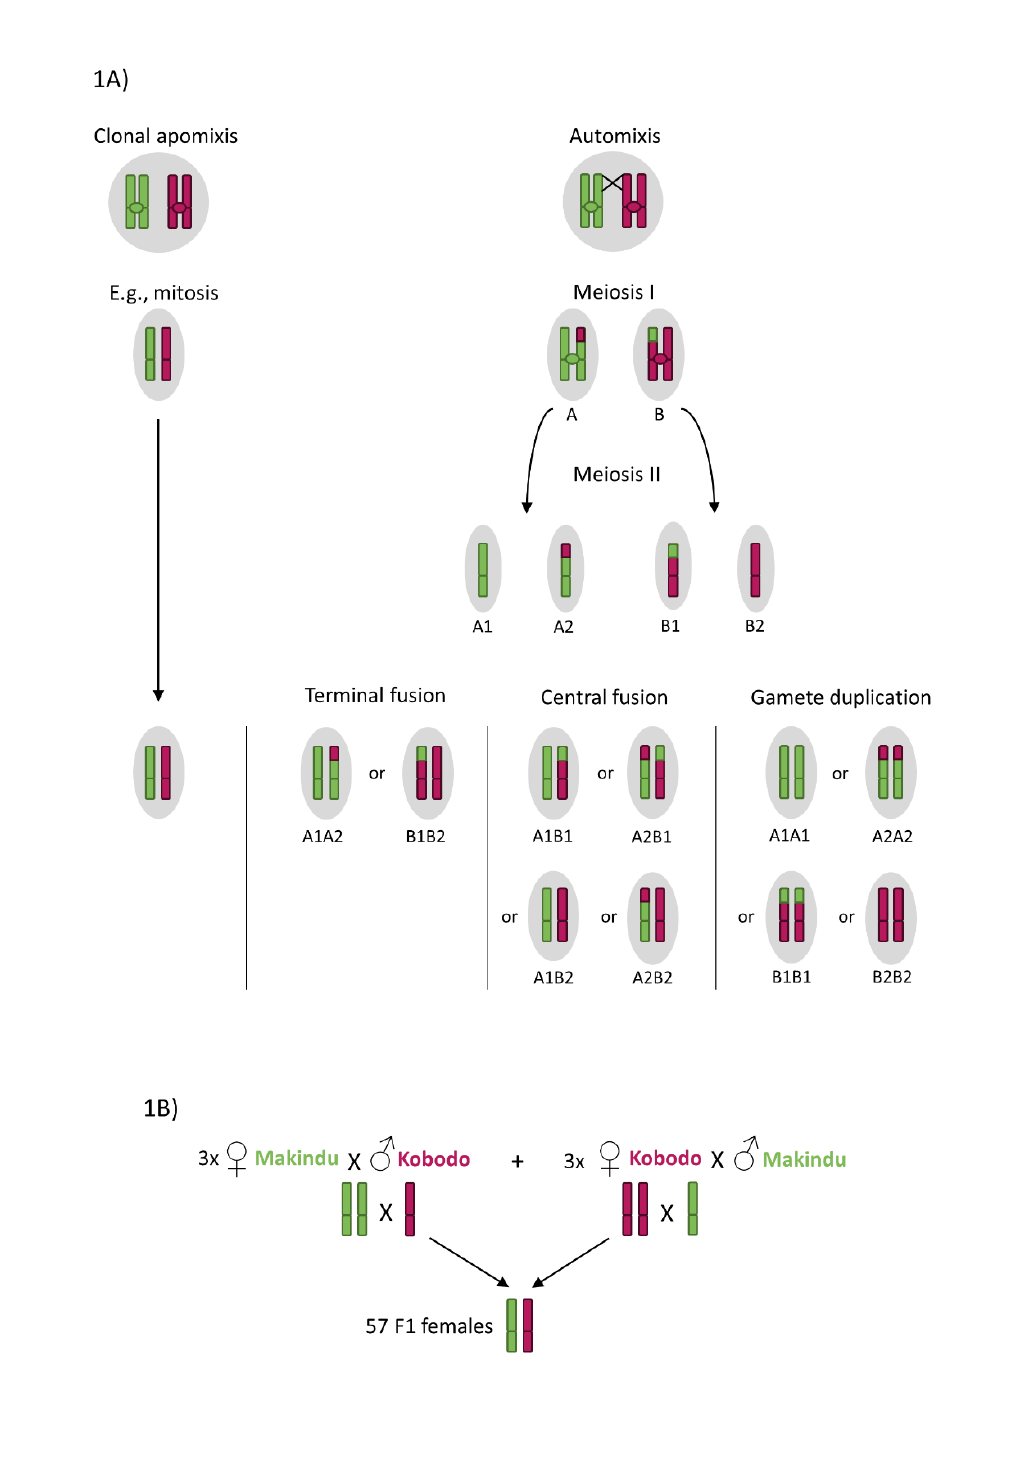
Figure 1: A) Expected genotype patterns of parthenogenetic daughters according to the main known thelytoky mechanisms. The cytological mechanisms are simplified because the figure focuses on the genetic consequences that can be achieved in different ways (see introduction for further details). The patterns can vary from complete loss of heterozygosity (under gamete duplication) to complete maintenance of heterozygosity (under clonal apomixis). B) Crosses performed in this study in order to obtain virgin heterozygous females. The analysis of recombination patterns of their daughters can give clues on the thelytoky mechanism